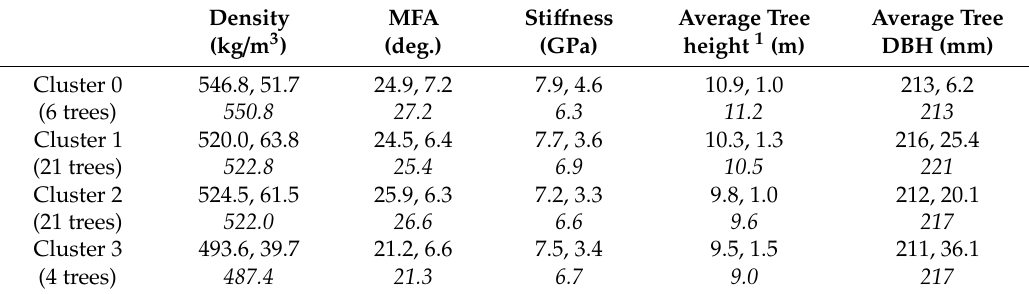
Figure 2. Trees determined to have similar wood properties based on complete linkage clustering with square Euclidian distance of near-infrared (NIR) spectral data. Table 1. Cluster means, standard deviations, and median values (in italics) for SilviScan determined wood properties (density, microfibril angle (MFA) and stiffness) and tree height and diameter at breast height (DBH).